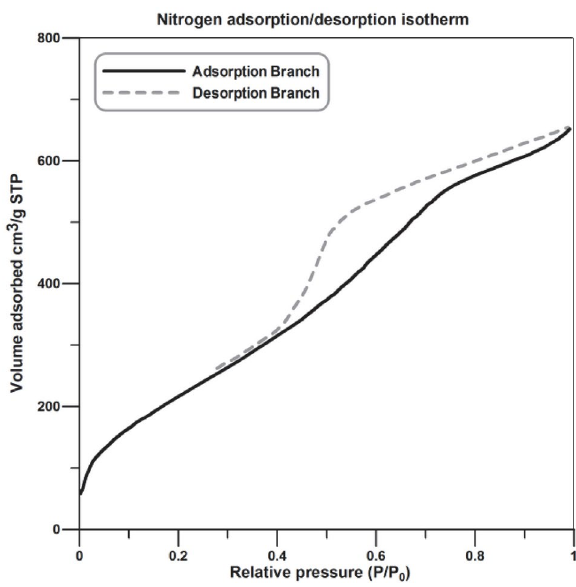
Figure 2. Nitrogen adsorption/desorption isotherm of the H-SAN According to extracted data from nitrogen adsorp- tion/desorption isotherm, BET surface area and average pore diameter of the synthesized aerogel (modified silica aerogel nanoparticles) are calculated 958.67 m 2 /g and 4.05 nm